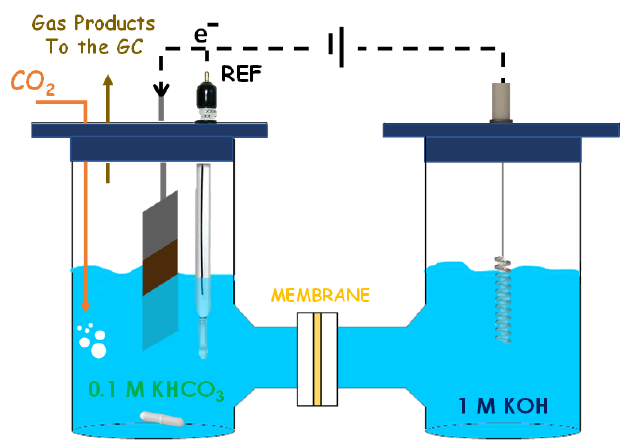
Figure 3. Simplified conceptual scheme of the electrochemical CO 2 reduction in H-cell